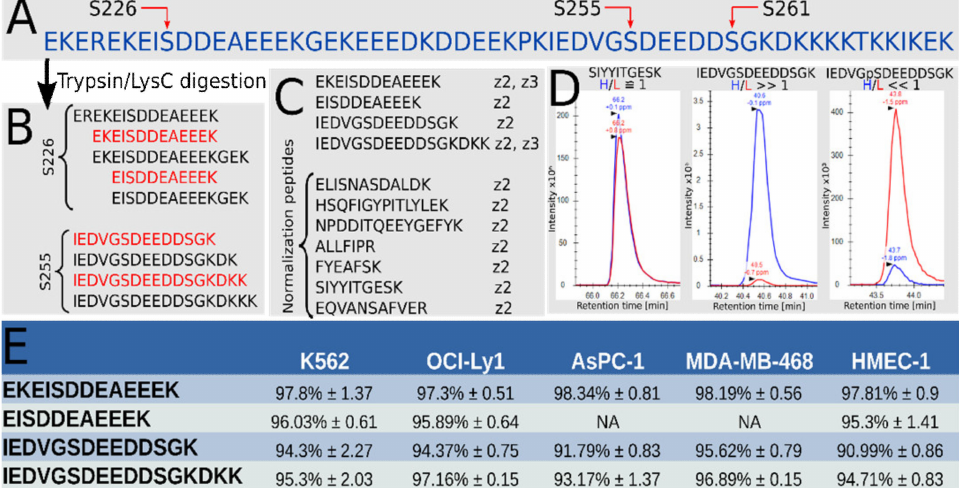
Figure 1. Determination of occupancy of CL phosphosites in human Hsp90 β (HSP90AB1). ( A ) Amino acid sequence of Hsp90 β ’s CL with S226, S255 and S261 indicated by red arrows. ( B ) Typical peptides spanning S226 or S255 resulting from a tryptic digestion of the CL. The peptides marked in red were selected for targeted MS. ( C ) The complete list of peptides selected for the targeted MS method and their charge state (z number). Normalization peptides are required to determine the H/L ratio for the whole protein. Both phosphopeptides and non-phosphopeptides from the CL were measured. ( D ) Typical chromatogram for a normalization peptide (here SIYYITGESK, left pane), a non-phosphopeptide from the CL (IEDVGSDEEDDSGK, middle pane), and its corresponding phosphopeptide (IEDVGpSDEEDDSGK, right pane). The chromatogram for the heavy (H) peptide is the blue curve, and the light (L) chromatogram the red curve. ( E ) Average and standard deviation of phosphorylation occupancy for 5 human cell lines ( n =